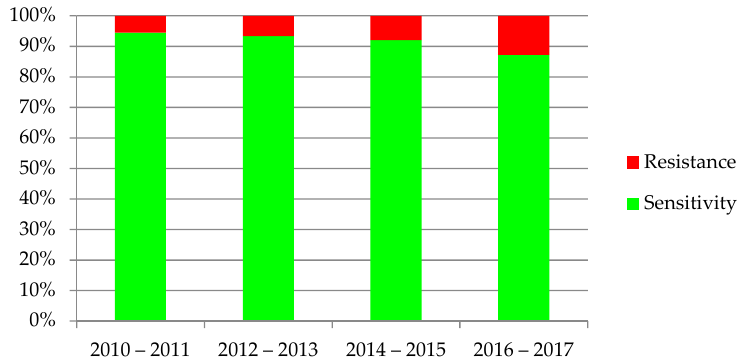
Figure 6. Sensitivity and resistance of bacteria to antibiotics from 2010–2017.